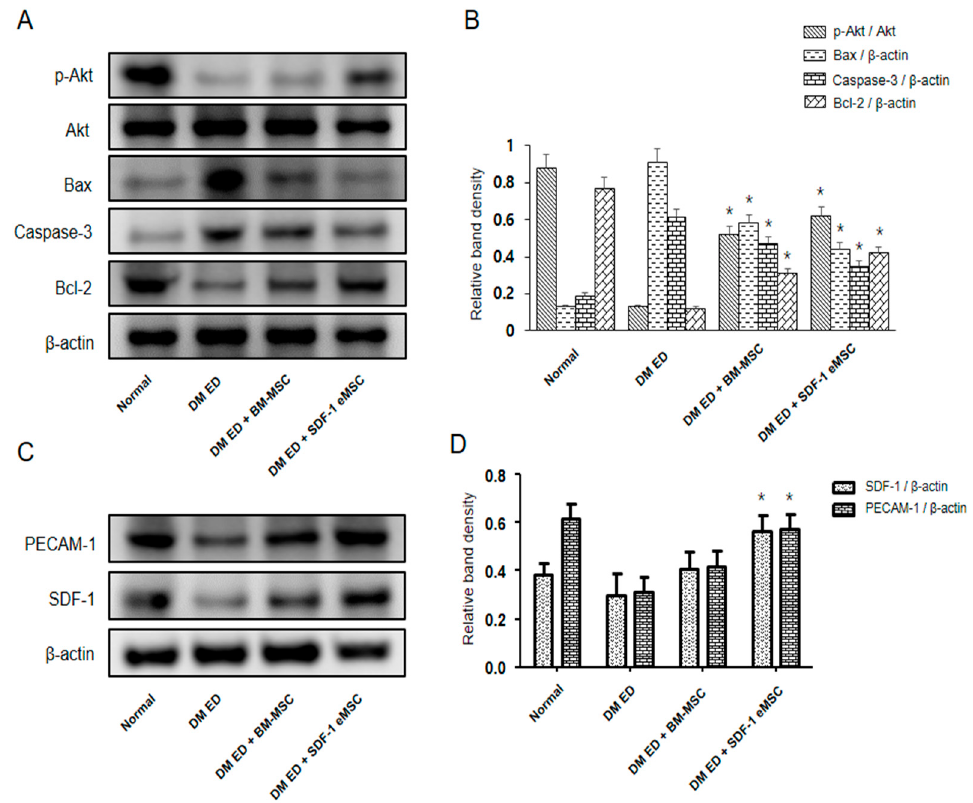
Figure 7. Protein expression in the corpus cavernosum. ( A ) All groups were compared with respect to p-AKT, AKT, Bax, Caspase-3, and Bcl-2 expression in the corpus cavernosum by western blotting. ( B ) Relative density of bands in the western blot analysis for each group. ( C ) All groups were compared with respect to PECAM-1 and SDF-1 levels in the corpus cavernosum by western blotting. ( D ) Relative density of bands in the western blot analysis for each group. Each bar shows the mean value (standard deviation). * p < 0.05 compared with the DM ED group.